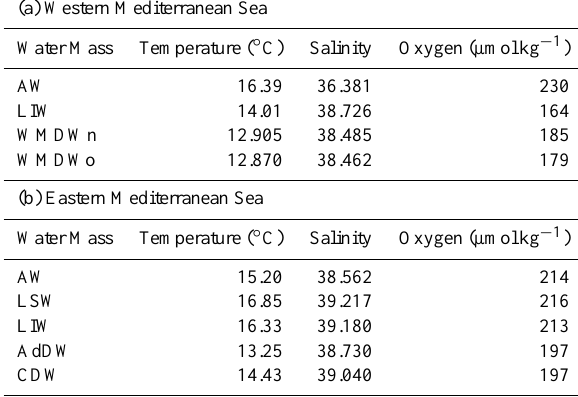
Table 1. Water masses and their characteristics for (a) the WMed and (b) the EMed. Acronyms used to define water masses: AW (Modified Atlantic Water), LSW (Levantine Surface Water), LIW (Levantine Intermediate Water), WMDWn (Western Mediterranean Deep Water new), WMDWo (Western Mediterranean Deep Water old), AdDW (Adriatic Deep Water), CDW (Cretan Deep